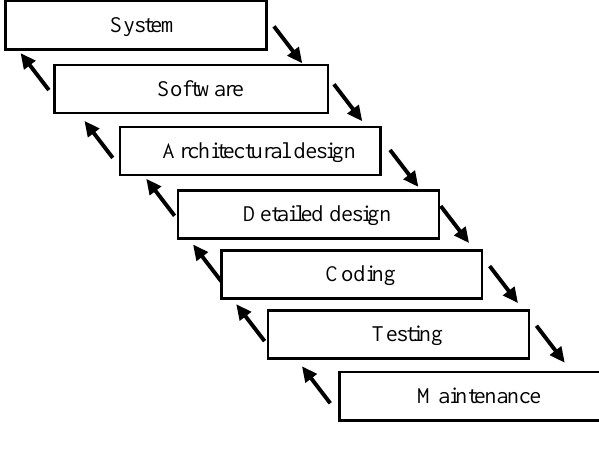
Figure 1. The WM Model